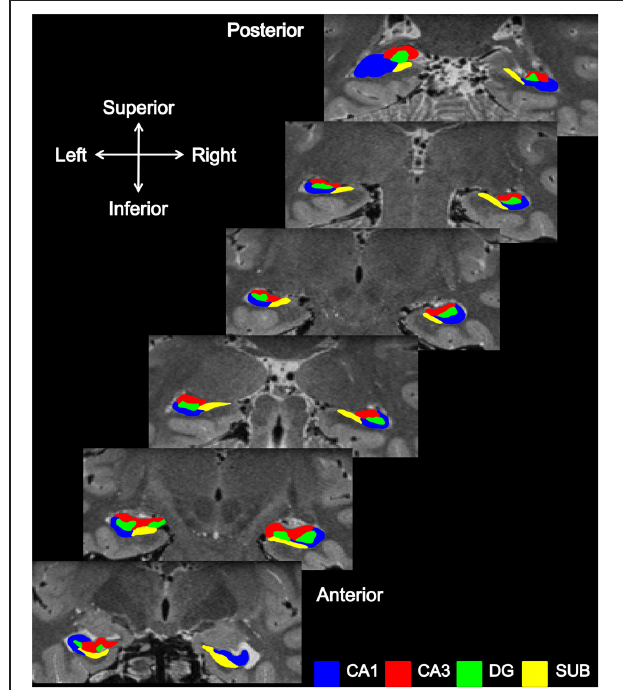
FIGURE 2 | Subfield segmentation in the coronal plane. Coronal sections through an averaged T2-weighted image of both the left and right hippocampus of a